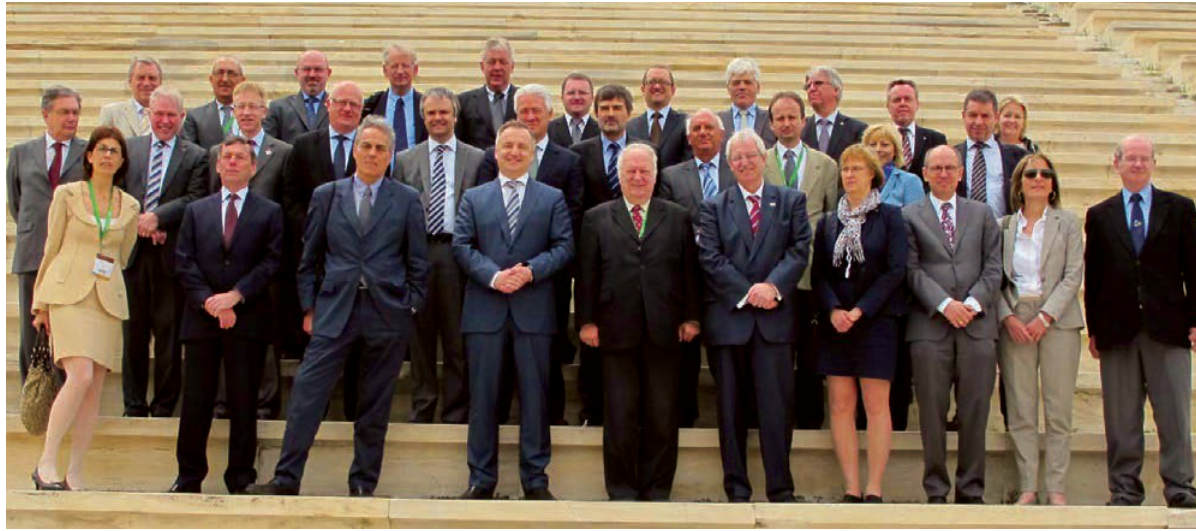
Fig. 1. CEDR Governing Board members in the Olympic stadium in Athens in 2012 At the first row from the left: Maura Sabato (Italy), Fred Barry ( Ireland), Dionysios Makris ( Greece), Skirmantas Skrinskas (Lithuania), Jyri Riimaa (Estonia), Joseph Kunz (Germany), Lena Erixon (Sweden), Jan Hendrik Dronkers (Netherlands), Aingeal Flanagan (CEDR), Michel Egger (CEDR) Second row from the left: Alberto Moreno (Portugal), Hreinn Haraldsson (Iceland), Graham Dalton (United Kingdom), Per-Erik Winberg (Sweden), Tom Roelants (Belgium (Flanders)), Stefano Granati (Italy), François Cazottes (France), Dirk de Smet (Belgium (Wallonia)), Gregor Ficko (Slovenia), Sylvia Meister (Switzerland), Rudolf Dieterle (Switzerland) Third row from the left: Algimantas Janušauskas (Lithuania), Bojan Leben (Slovenia), Zsolt Völgyesi (Hungary), Joris Al (Netherlands), Ivars Pāže (Latvia), Mārtiņš Dambergs (Latvia), Simon Grima (Malta), Per Jacobsen (Denmark), Terje Moe Gustavsen (Norway), Raimo Tapio (Finland), Nicola Risley